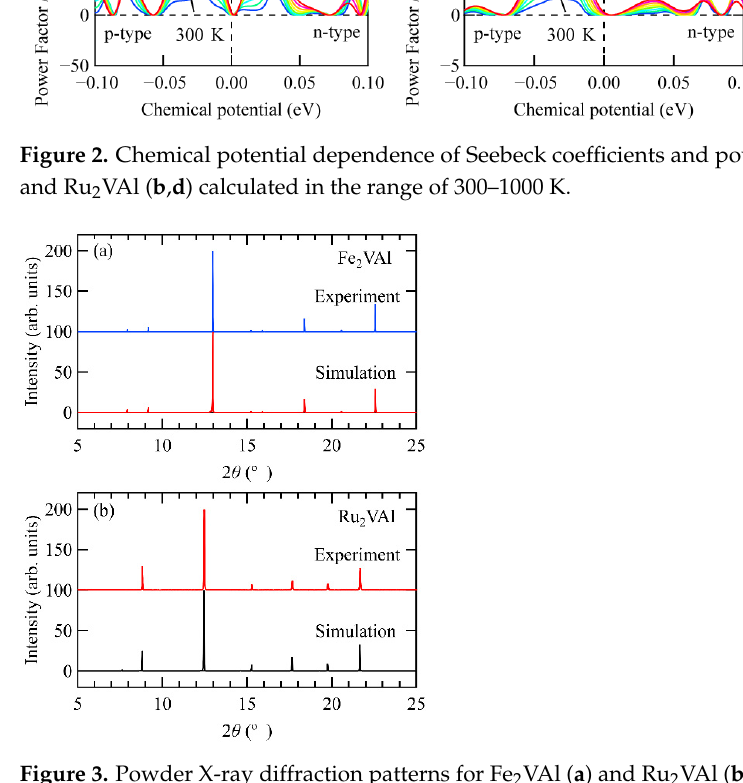
Figure 2. Chemical potential dependence of Seebeck coefficients and power factor for Fe 2 VAl ( a , c ) and Ru 2 VAl ( b , d ) calculated in the range of 300–1000 K.